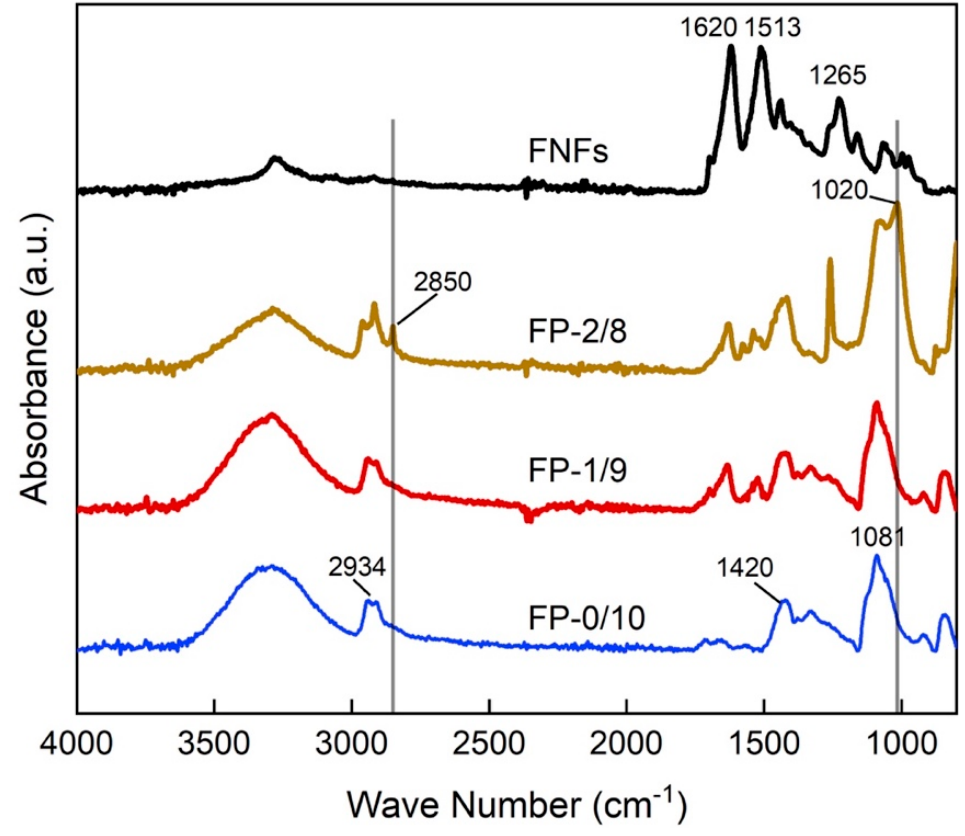
Figure 4. FT-IR spectra of the PVA, FNFs, and FNFs/PVA composite nanofibers. For the high FNFs contained fibers (FP-2/8), a new peak at 1020 cm − 1 for C-O stretch- ing vibration was significantly strengthened, and another new peak at 2850 cm − 1 attributed to C-H stretching vibration from alkyl groups appeared in the vicinity of the duplet ab- sorption peak at 2934 cm − 1 . These results suggest that the intermolecular hydrogen bonds between the hydroxyl group of PVA and the hydroxyl group of the amide group side chain, such as tyrosine and serine, exposed on the surface of FNFs occurred in